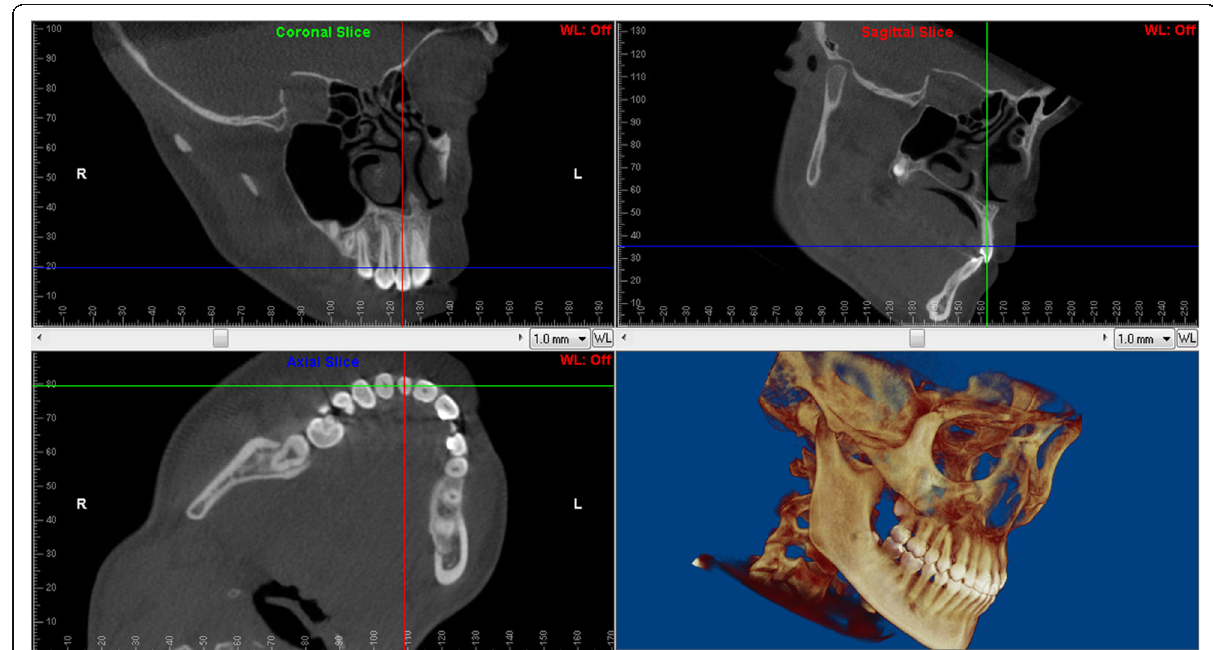
Fig. 1 Volumetric rendering, sagittal, coronal, and axial sections parallel to the long axis of maxillary central incisor, through the center of the